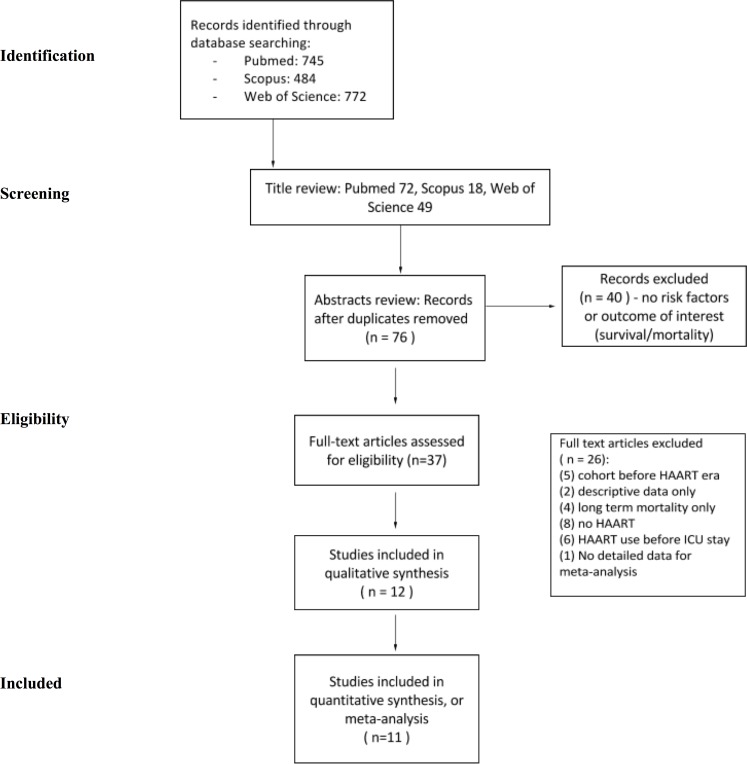
Highly active antiretroviral therapy systematic review and meta-analysis flowchart.HAART systematic review flowchart, which shows the procedure used for the selection of the articles for the qualitative and quantitative synthesis. HAART highly active antiretroviral therapy; ICU intensive care unit. PRISMA Model Flow Diagram [24].